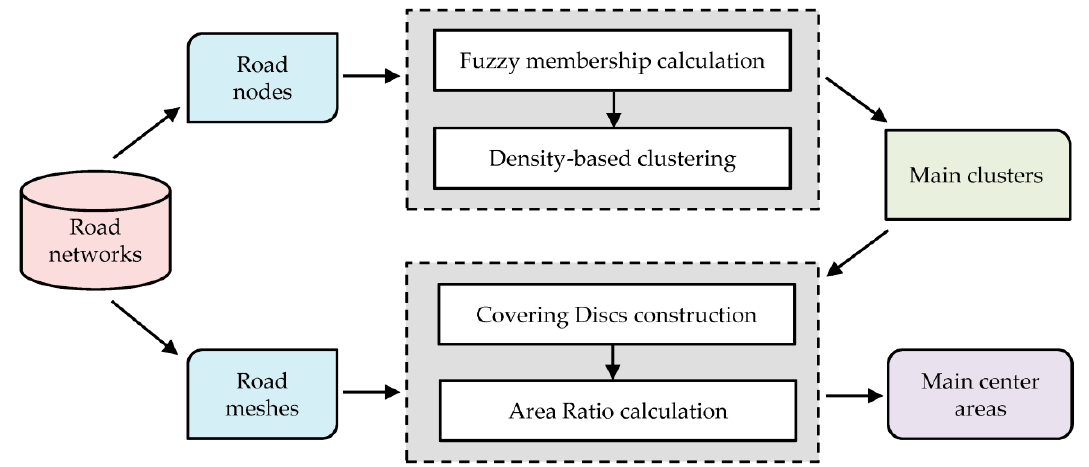
Figure 1. Schematic diagram of the main center pattern recognition.